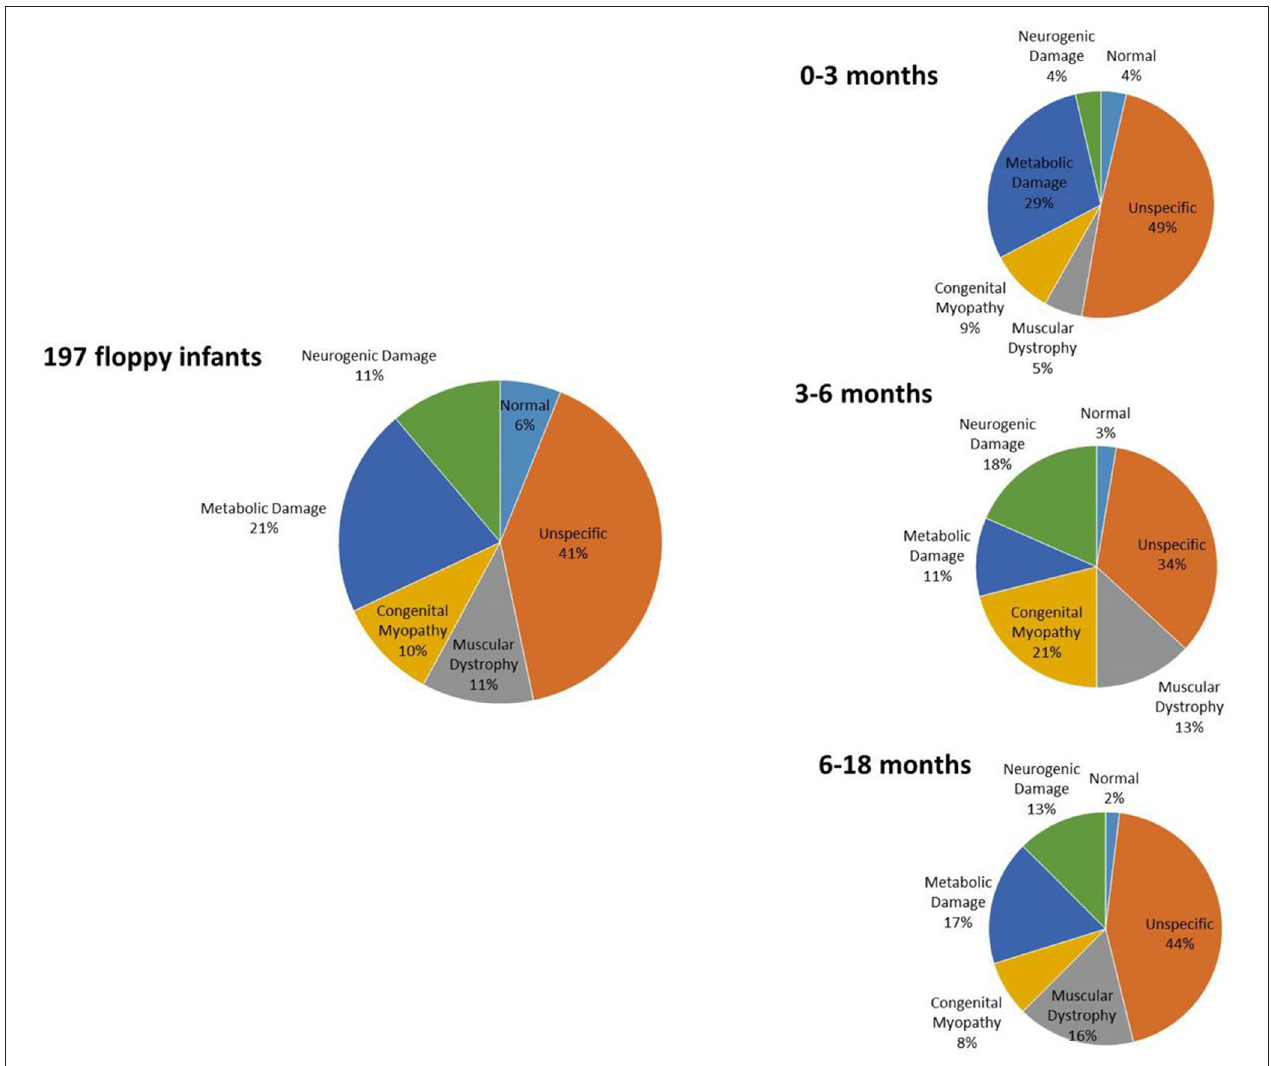
FIGURE 1 | Distribution of histopathology